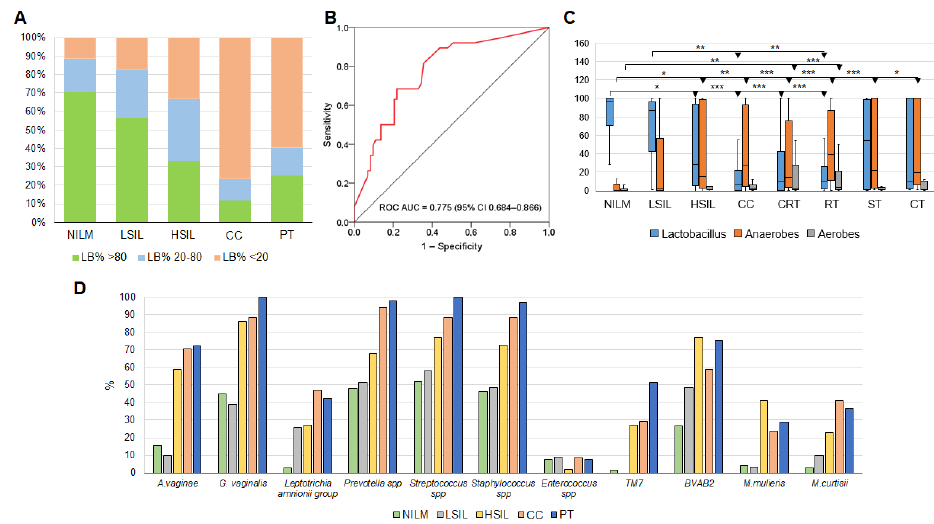
Figure 8. ( A ) At different diagnoses and post-treatment, stratification of cytological specimens by LB proportion based on BioFlor Kit analysis results. ( B ) The receiver-operating characteristic curve derived from training sample analysis for the detection of ≥ HSIL based on the non-LB DNA per- centage assessed by the BioFlor Kit. ( C ) Relative abundance of lactobacilli, common BV-associated anaerobes ( Gardnerella vaginalis , Atopobium vaginae , Prevotella spp., and the Leptotrichia amnionii group summarized) and common AV-associated aerobes ( Streptococcus spp., Staphylococcus spp., and Enterococcus spp. summarized) assessed by the BioFlor Kit at different diagnoses and in differ- ent PT subgroups. CRT, chemoradiotherapy; RT, radiotherapy; ST, surgical treatment; CT, com- bined therapy. Differences between groups were evaluated by the Mann–Whitney U test with Bon- ferroni’s correction for multiple testing; an adjusted p -value was calculated as a pairwise nonad- justed p -value multiplied by the total number of comparisons. The figure presents the median value, upper and lower quartiles, and a nonoutlier range; outliers are not shown. *** p ≤ 0.001; ** 0.001 < p < 0.01; * p < 0.05. ( D ) Frequency of detection of different opportunistic bacteria (as a percentage of the total number of analyzed samples) at different diagnoses and post-treatment using the BioFlor Kit, RealBest Mobiluncus mulieris/Mobiluncus curtisii DNA Kit, and RealBest Saccharimonas aal- borgensis (TM7)/BVAB2 DNA Kit.